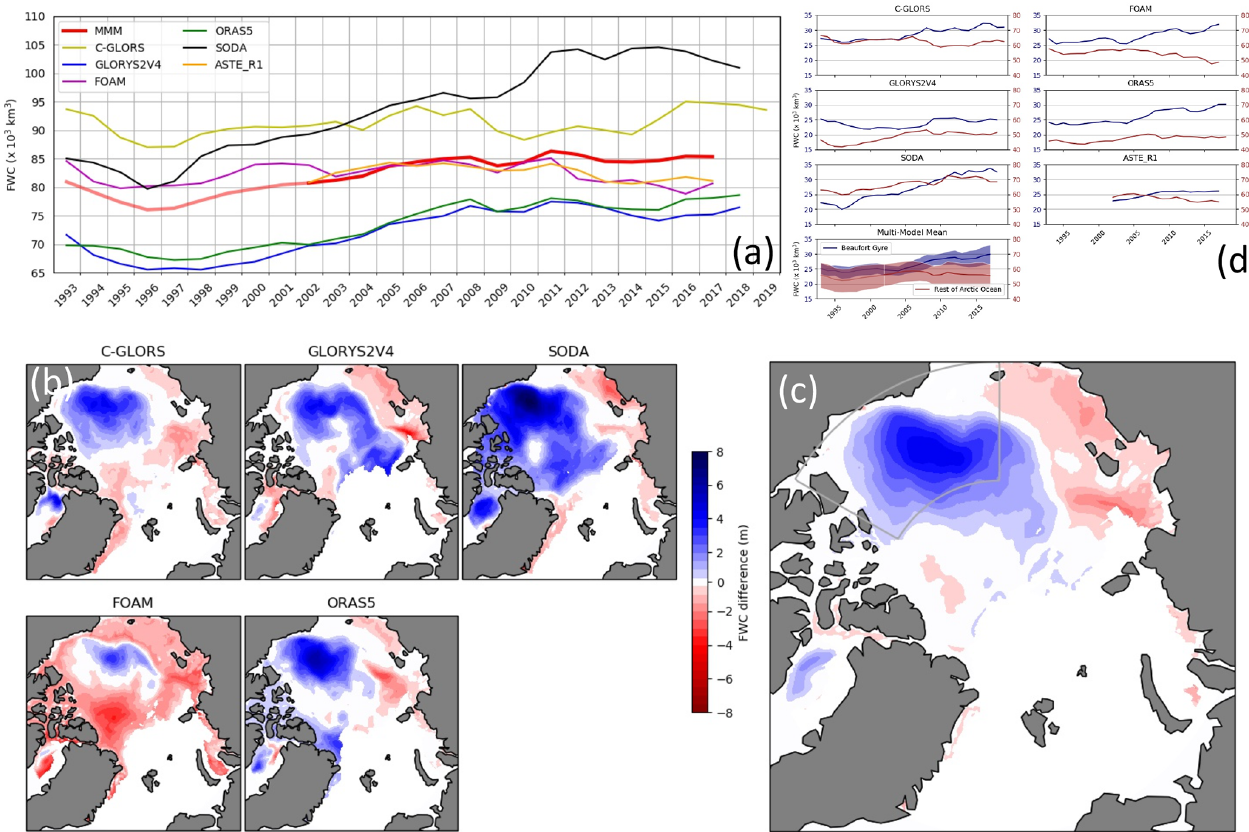
Figure 2. Ordered counterclockwise: (a) Time series of annual freshwater content integrated from 70–90 ◦ N and down to the 34 isohaline for the 1993–2019 period from six ORAs (in 10 3 km 3 ). Multi-model mean shown in red; darker red indicates all six ORAs are included. (b) Difference (inm) between 2010–2017 and 2000–2010 means in five ORAs (not including ASTE_R1). (c) Multi-model mean of differ- ences (inm) shown in (b) . (d) Annual freshwater content separated into contributions from the Beaufort Gyre (blue) and the rest of the Arctic Ocean (red). The lower right figure shows the multi-model mean with ± 1 standard deviation shown with shading. The Beaufort Gyre is defined as 70–80 ◦ N, 120–180 ◦ W to be consistent with the satellite estimates